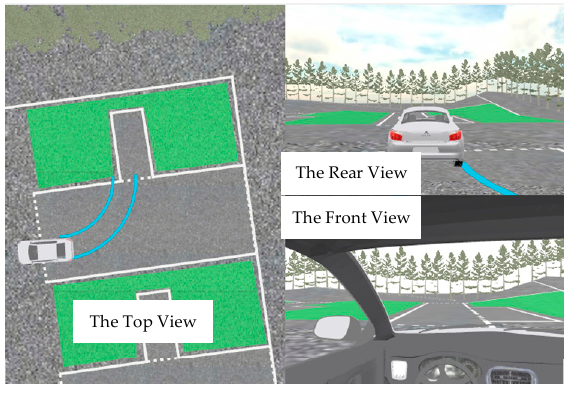
Figure 14. The interface of AI-DTS.